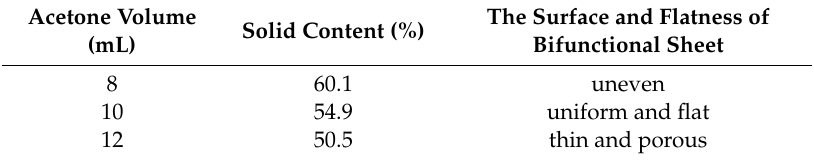
Table 1. E ff ect of solid content on the surface and flatness of bifunctional